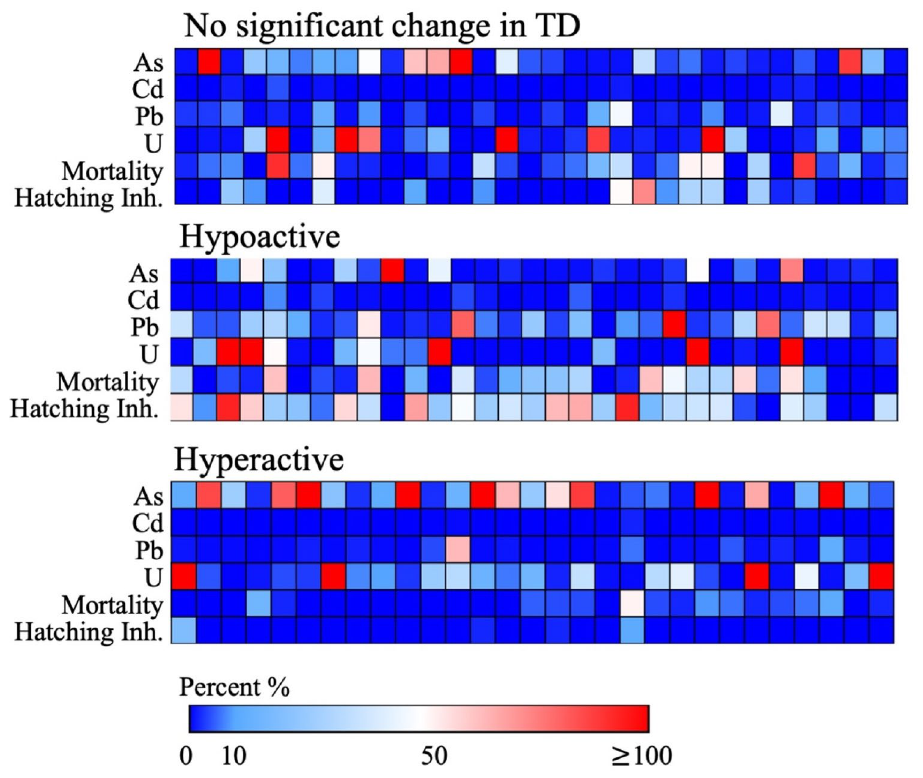
Figure 2. Heat map, representing concentration of a given metal as a percent of its maximum contaminant level (MCL) in a drinking water sample; MCLs for arsenic (As)—10 ppb, cadmium (Cd)—5 ppb, lead (Pb)—15 ppb, and uranium (U)—30 ppb. Percent mortality and hatching inhibition at 5 dpf are also included. Samples are further categorized into exposures that resulted in no significant change in larval total distance (TD)